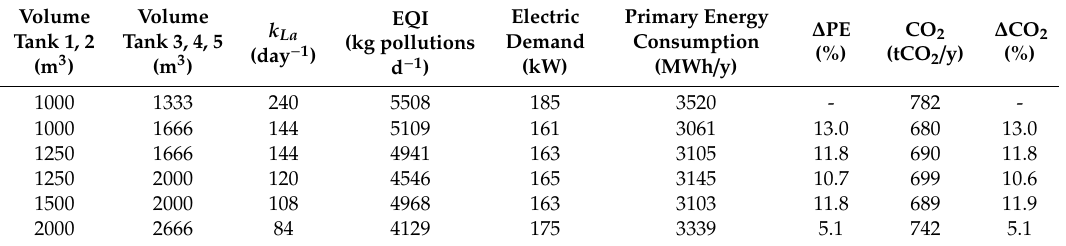
Table 4. Primary energy consumption and CO 2 emission comparison using di ff erent tank